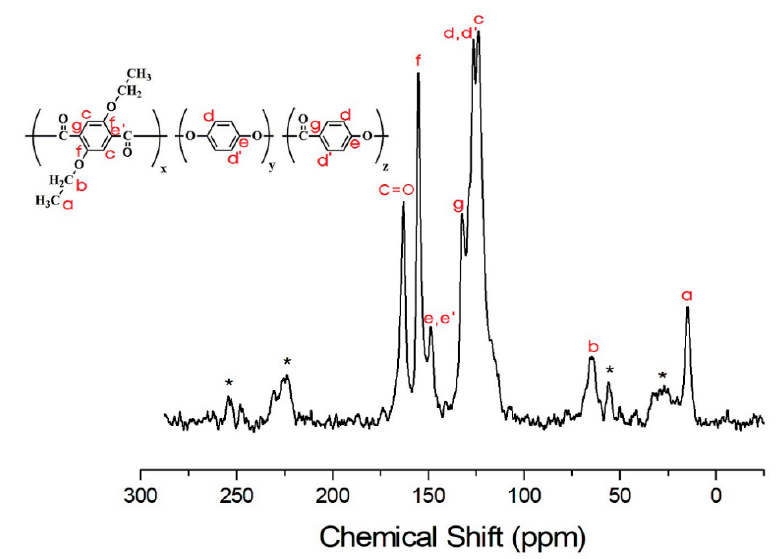
Figure 9. 13 C-NMR chemical shifts of sample I-A at room temperature. In the chemical formula, x:y = 1:1. The spinning sidebands are marked with asterisks.